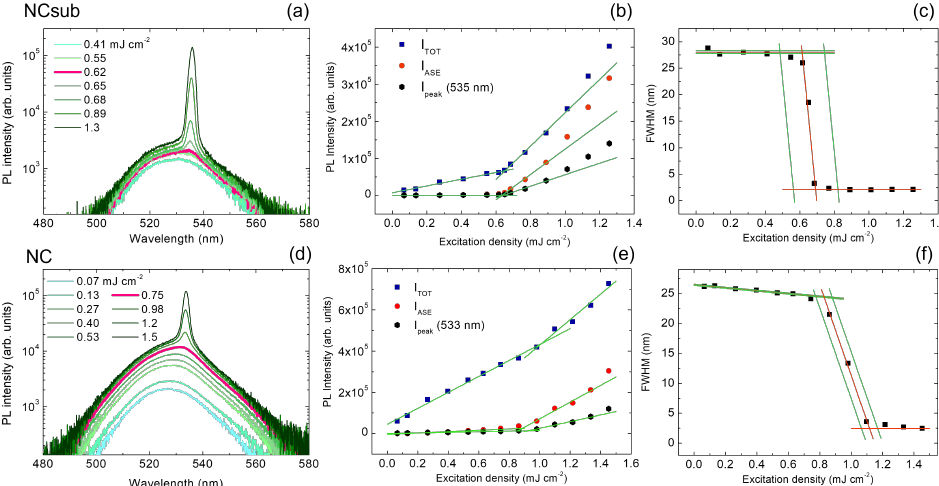
Figure 2. ( a – d ) Excitation density dependence of the PL spectra. The thicker pink line evidences the first spectrum in which the lineshape is modified by the ASE presence. ( b – e ) Excitation density dependence of the total integrated intensity (I TOT ), the ASE integrated intensity (I ASE ) and ASE peak intensity (I peak ). Green lines represent the best-fit curves. ( c – f ) Excitation density dependence of the spectral linewidth (FWHM). The red lines are the best-fit curves and the green lines are the limits of the uncertainty range. The top and bottom rows show the results for NCsub and NC,